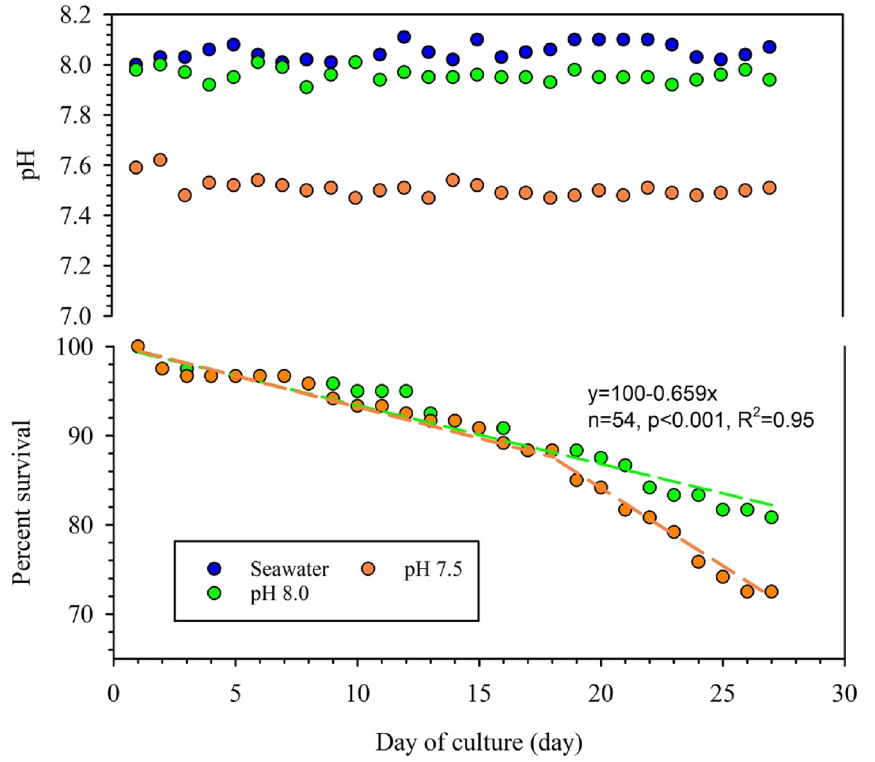
Figure 1. Time courses of pH and percent survival of shrimp during the culture periods Blue circles = source seawater; green circles = seawater in pH 8.0 tanks; orange circles = seawater in pH 7.5 tanks. The green and orange broken lines are regression lines representing the percentage of surviving shrimp in the pH 8.0 and pH 7.5 tanks,